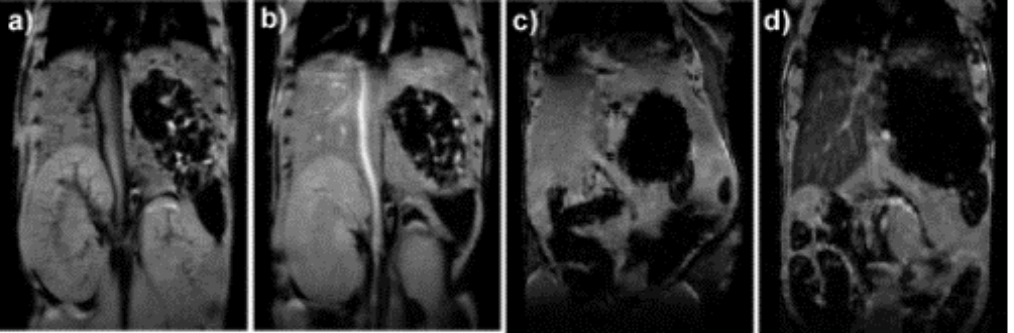
Figure 4. (a) Precontrast and (b) postcontrast (2.1 µmol/Kg dose) T image showing aorta signal enhancement; (c) Precontrast and (d) postcontrast (31 µmol/Kg dose) mouse MR images showing liver signal loss due to T Reproduced with permission from [68] ® 2008, American Chemical